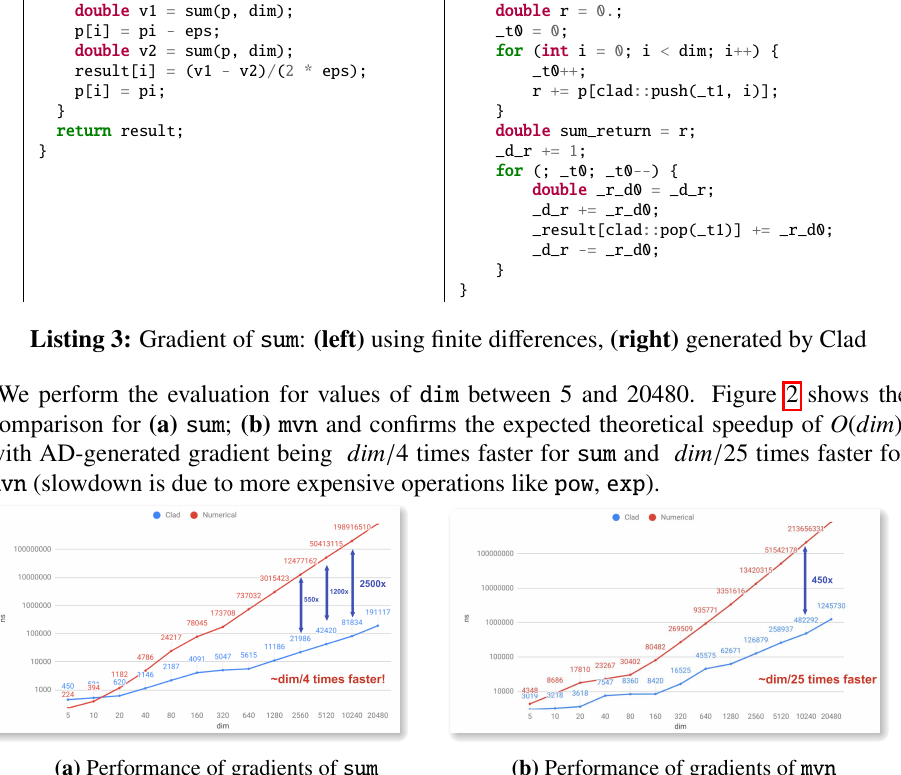
Figure 2: Comparison of reverse mode AD and ND with increasing